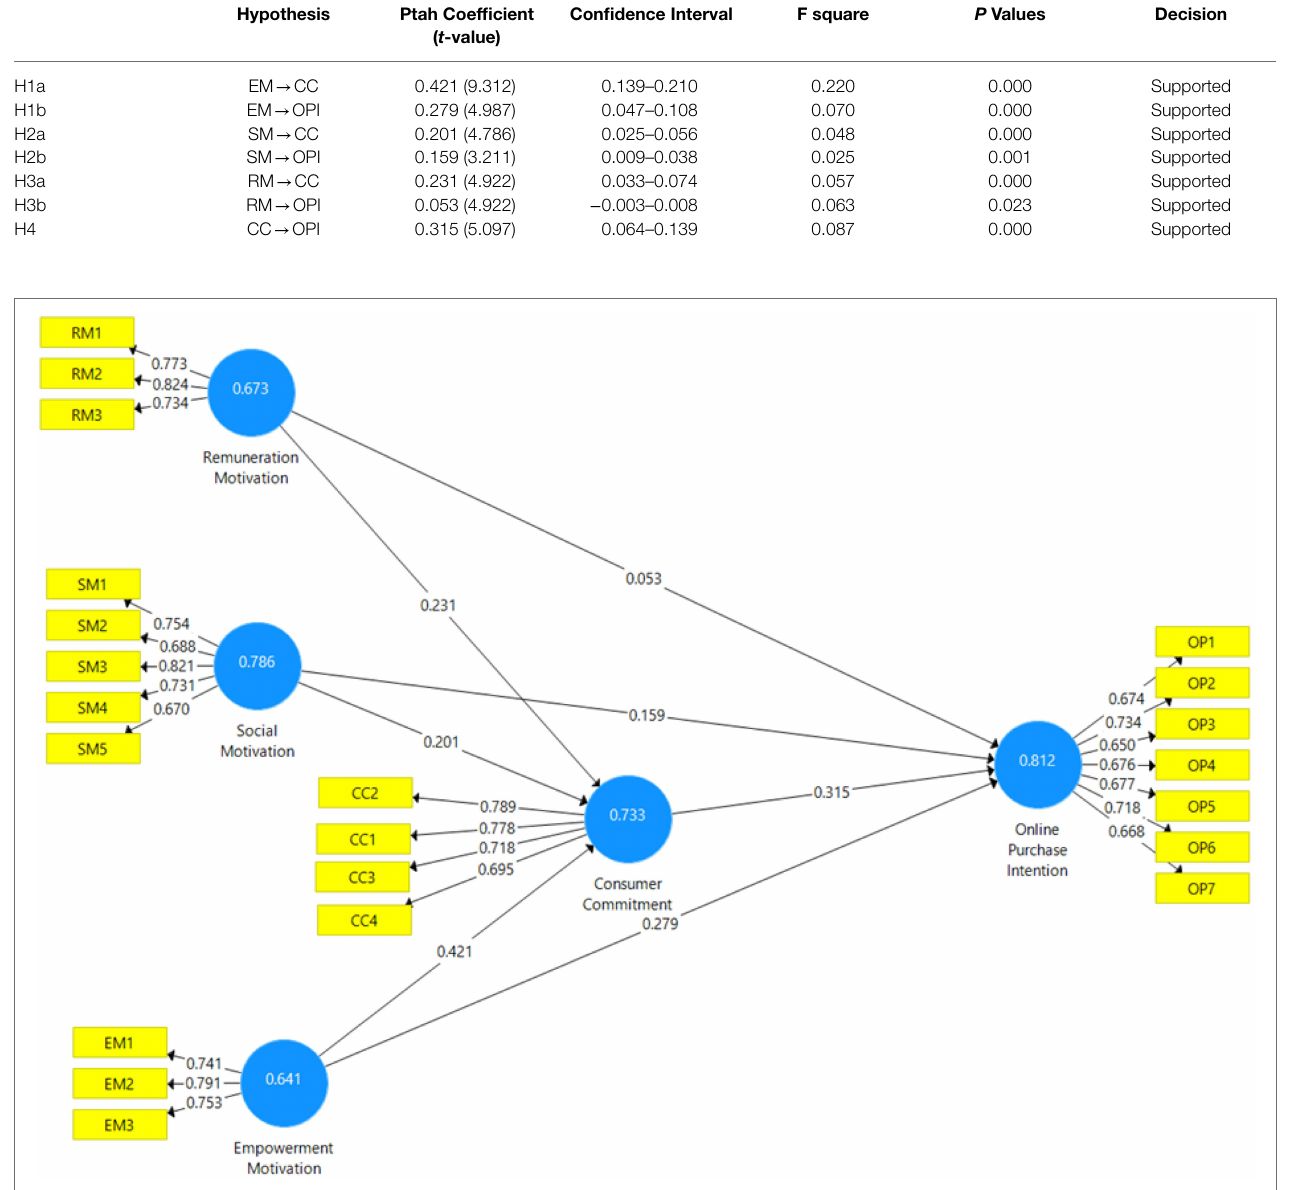
TABLE 3 | Hypothesis testing.